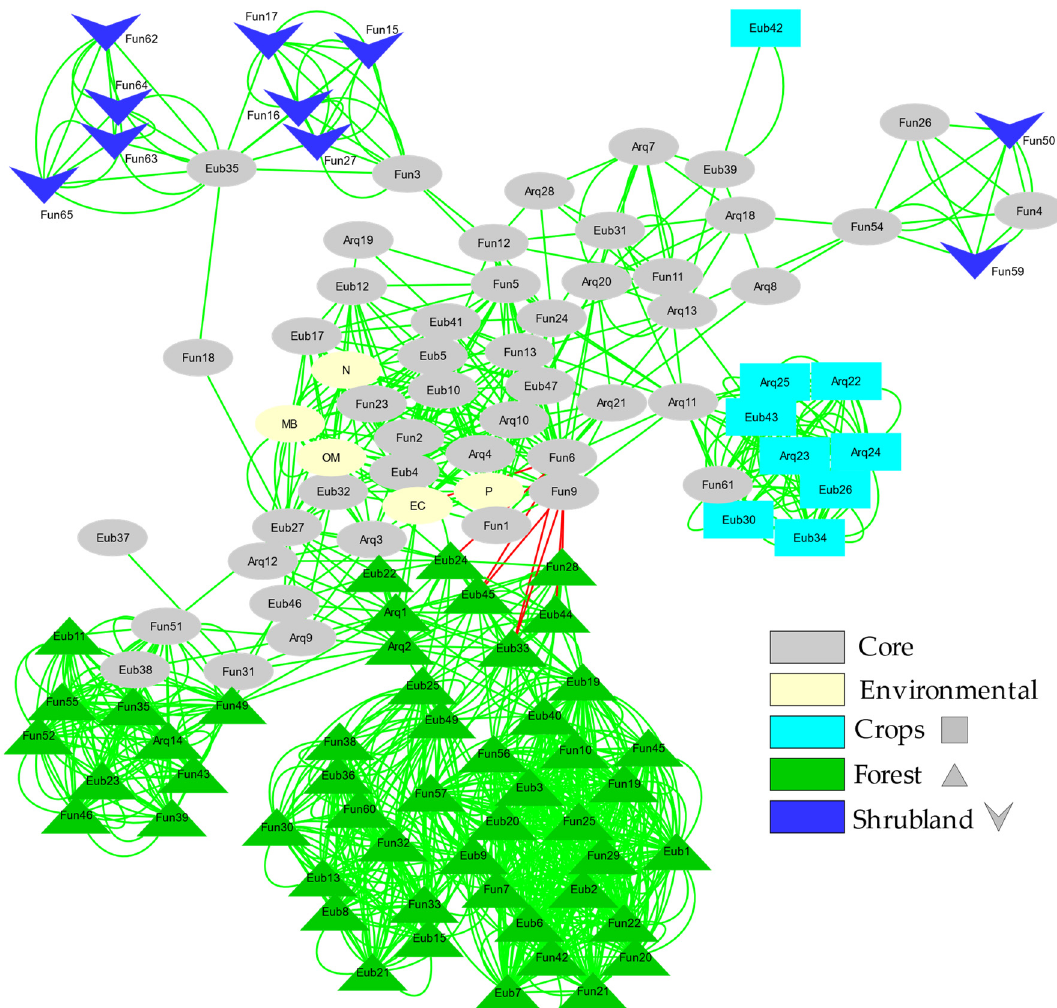
Figure 5. Bray Curtis and mutual exclusion Network of the fingerprinting profiles for Bacteria, Archaea and ectomycorrhizal Fungi. Each factor (Forest; Shrubland; Crops) presents its own code of colour, the nodes were assigned to a specific factor if the relative band intensity represents more than 90% in that factor. If the relative abundance was lower than 90% and the ZOTU was shared between others factors it was classified as a Core node.